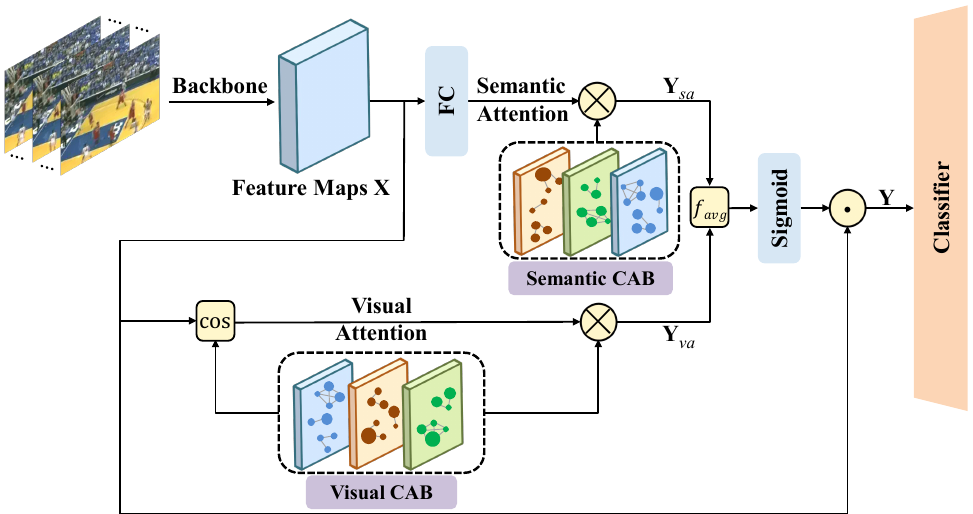
Figure 2. The architecture of our relational action bank with semantic–visual attention module. This module includes relational action bank and semantic–visual attention submodules. (cid:12) denotes the element-wise multiplication. ⊗ denotes matrix